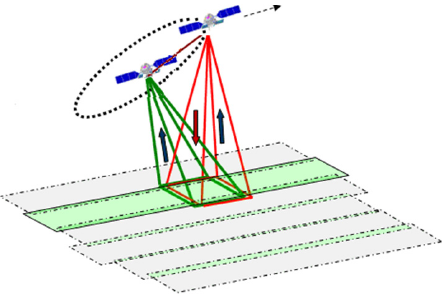
Figure 1. Schematic view of TH ‐ 2A and TH ‐ 2B in operation.